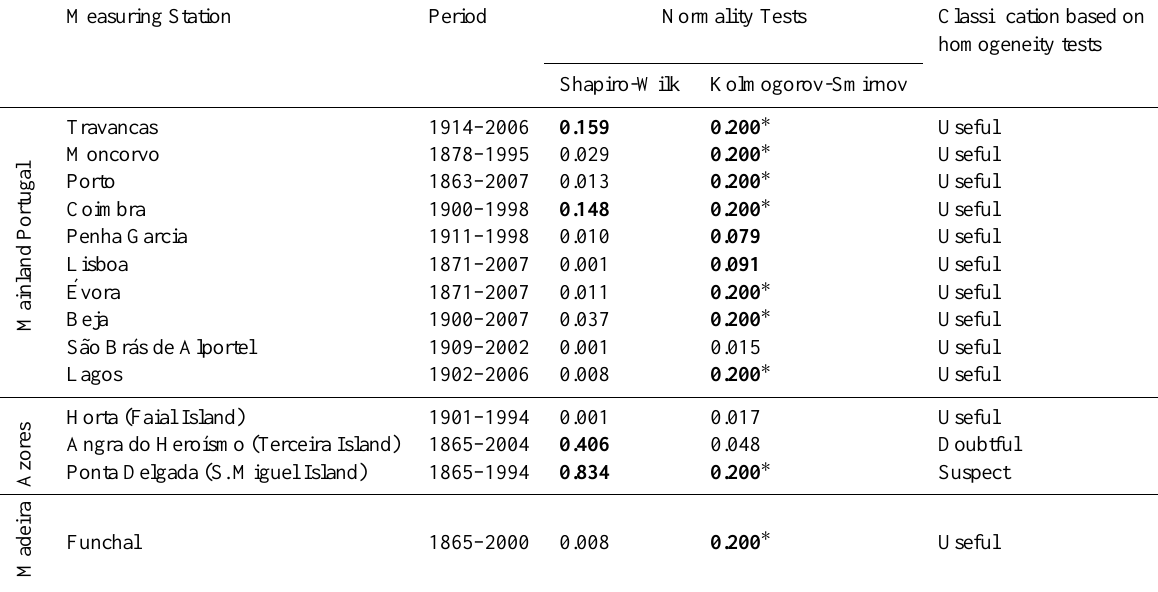
Table 2. Statistics of the Shapiro-Wilk and Kolmogorov-Smirnov tests for normality, applied to the annual precipitation time series. The results in bold indicate which series have normal distributions for a 5% significance level. The ∗ mark indicates that the result is a lower bound of the true significance. The classification of the time series as “useful”, “doubtful” and “suspect” is based on the results of the homogeneity tests, as proposed by Wijngaard et al.